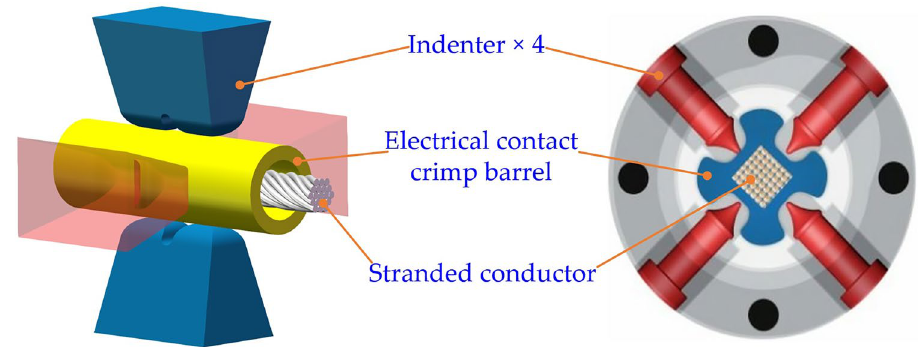
Figure 1. Four-indenter-eight-indentation crimping method for aviation electrical